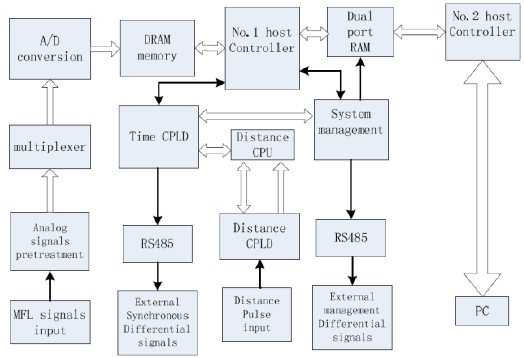
Figure 11. Diagram of the high-speed data collection system structure.